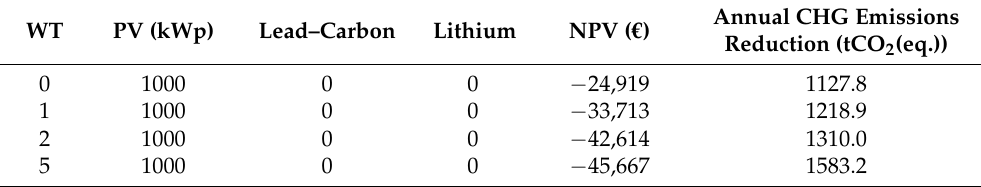
Table 5. Pareto-optimal set of the HMU campus microgrid for the autoproducer